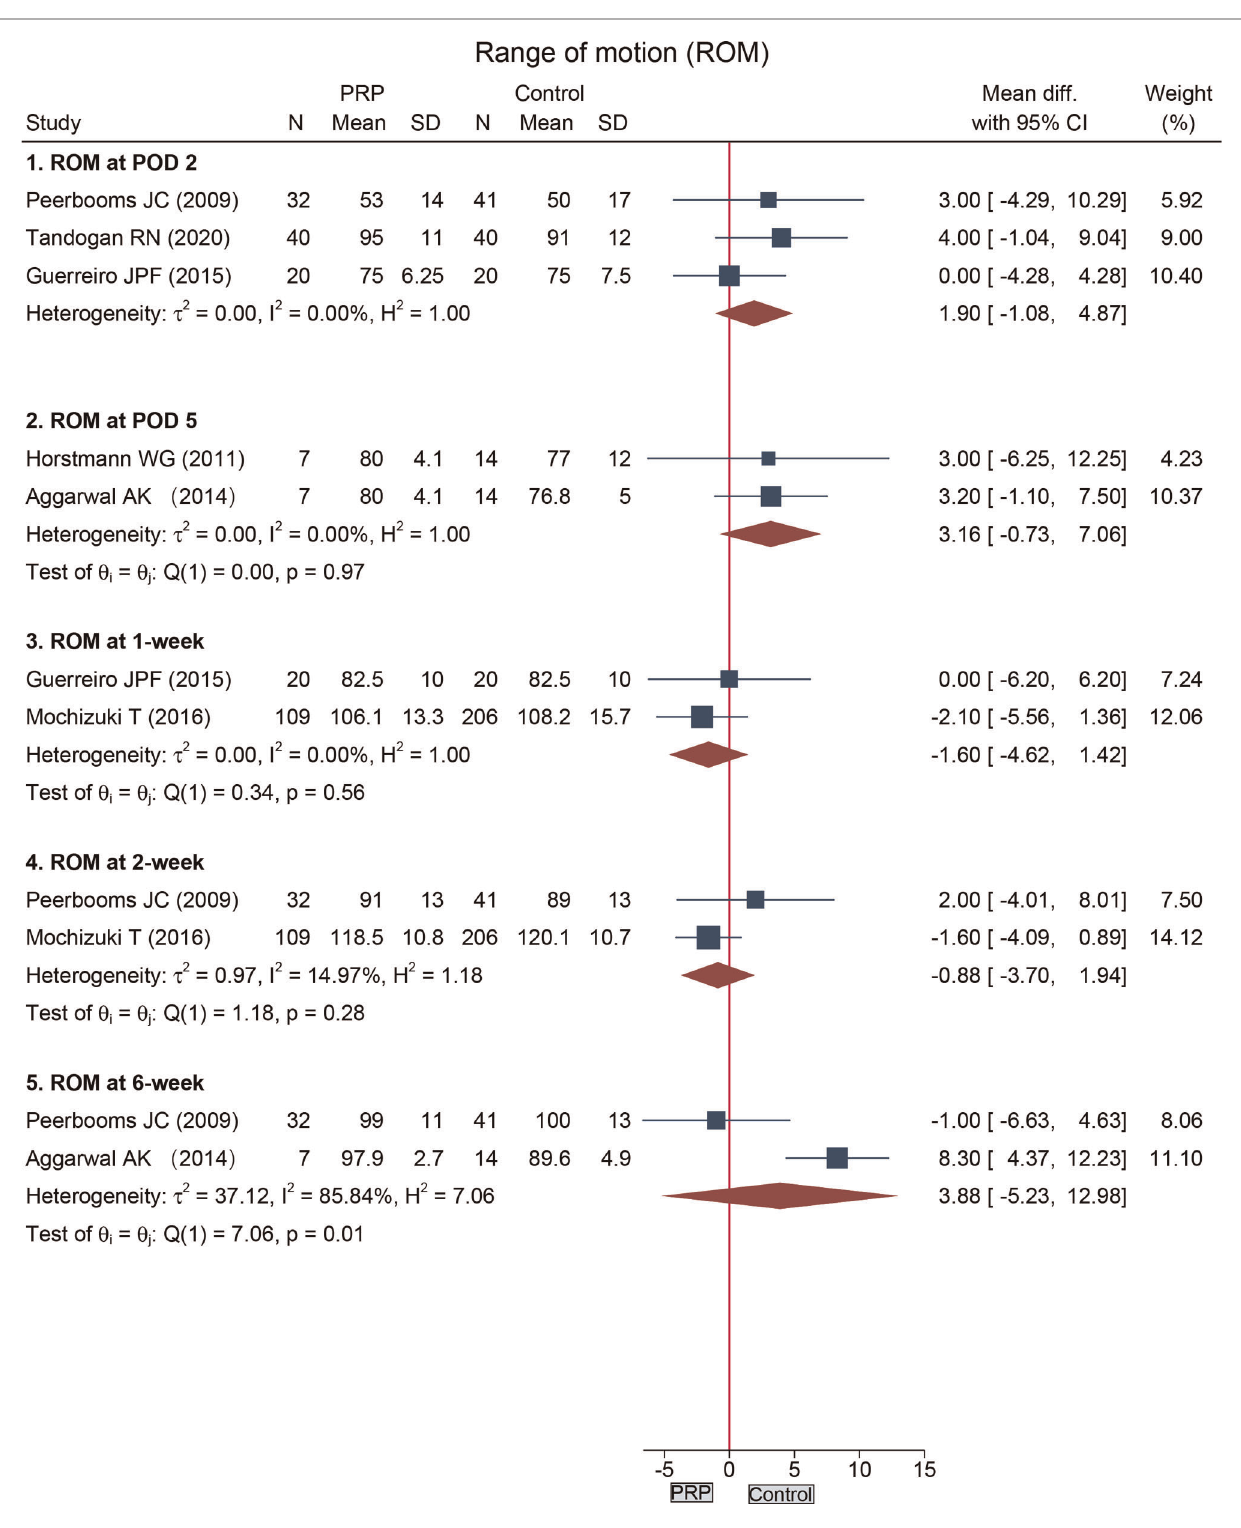
FIGURE 4 | Forest plot presents the pooled results for the range of motion in the total knee arthroplasty subgroup.